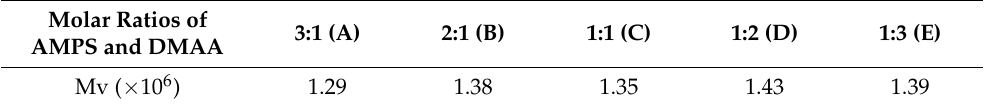
Table 2. The relative molecular weights of the copolymers with different charge densities (AMPS and DMAA molar ratios).